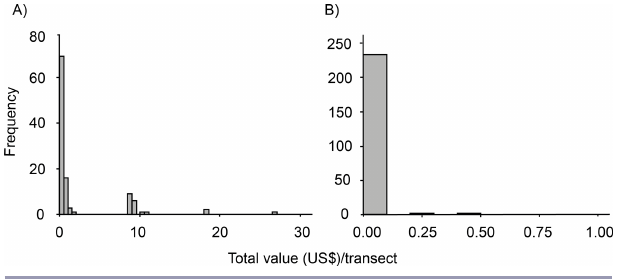
Fig. 3 . Frequency of sea cucumbers in comparable transects by economic value (US$) in (A) Mayotte (n = 109) and (B) Zanzibar (n = 235). All three species are pooled in this figure. Highest value for a transect in Mayotte was estimated to be US$26.80, whereas for Zanzibar it was